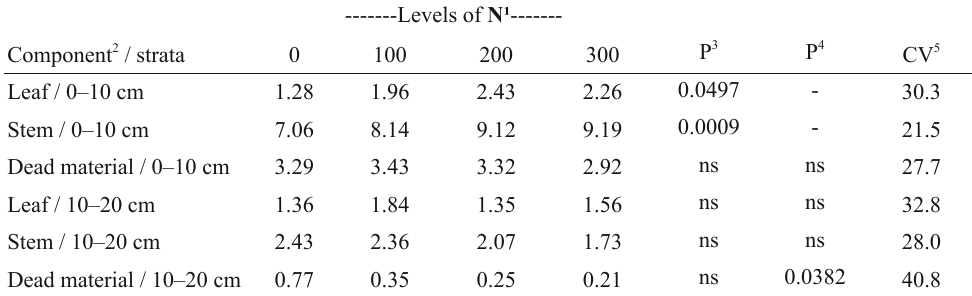
Bulk density of the structural components of the sward (leaves, stems and dead material) of Alexandergrass in the 0-10 and 10-20 cm strata according to N